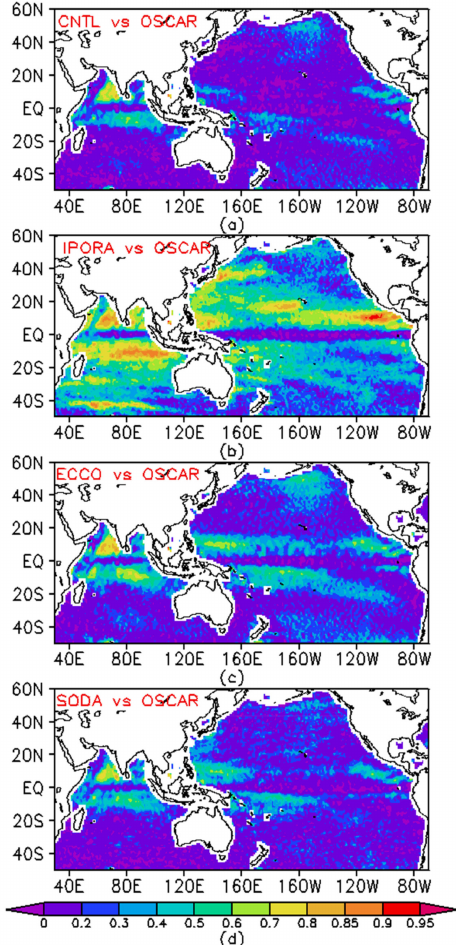
Figure 9. Time correlation with OSCAR surface meridional currents from ( a ) CNTL, ( b ) IPORA, ( c ) ECCO, and ( d ) SODA for the period of 1993–2011.